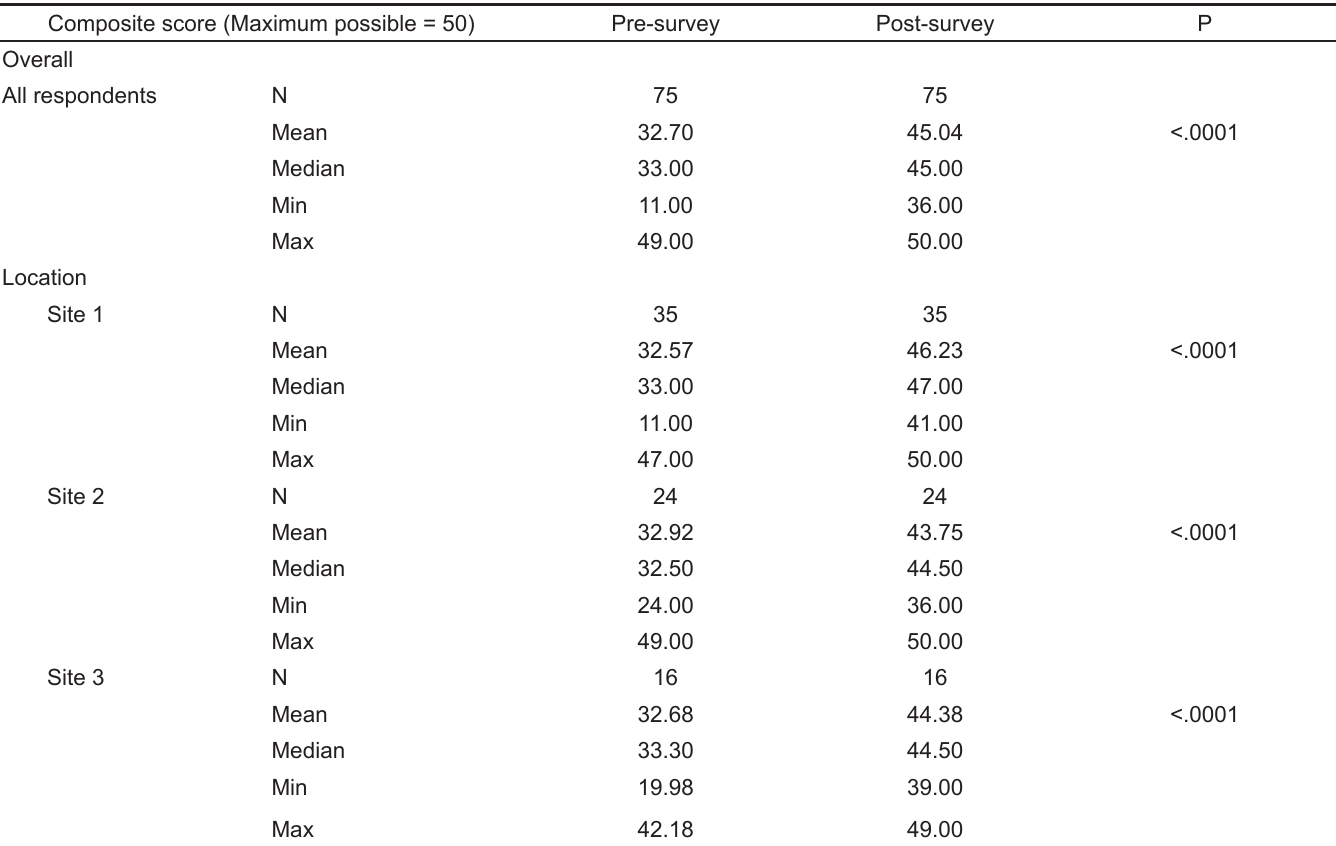
Table 4. Composite scores for 75 respondents who responded to both pre- and